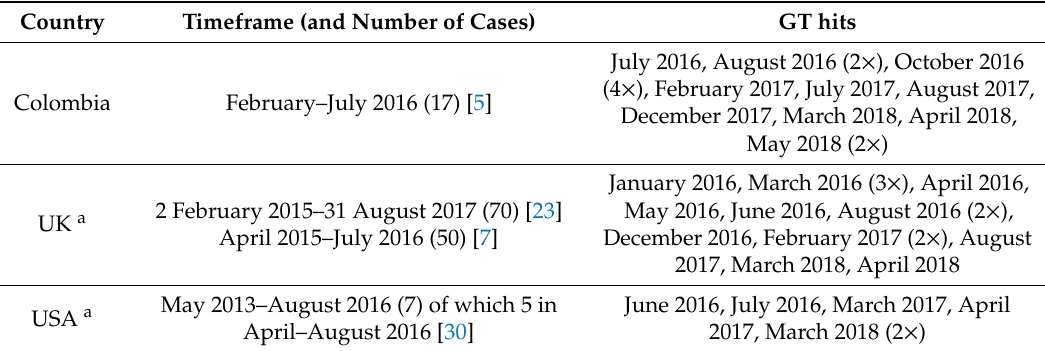
Table 2. A light grey shading of the overlap in the published C. auris cases or clusters and GT hits for 2016 to the middle of